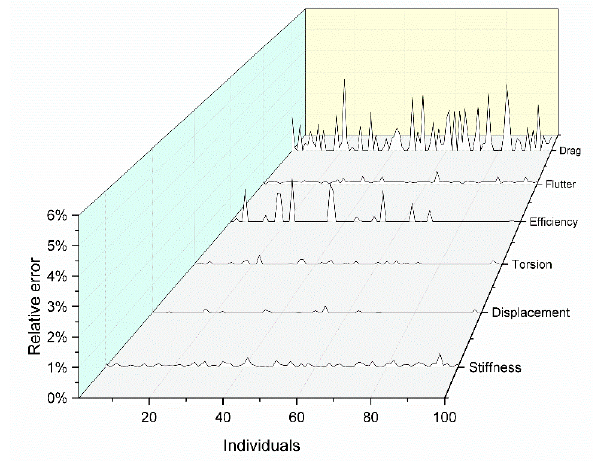
Figure 7. Accuracy of the GP model verified by 100 sampling points.